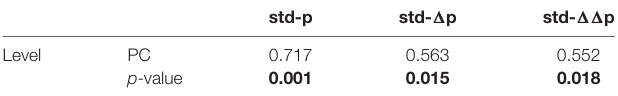
TABLE 2 | Significant handwriting features assessed by Pearson’s partial correlation controlled for brain volume; significant values for p -value < 0.01 and p -value < 0.05